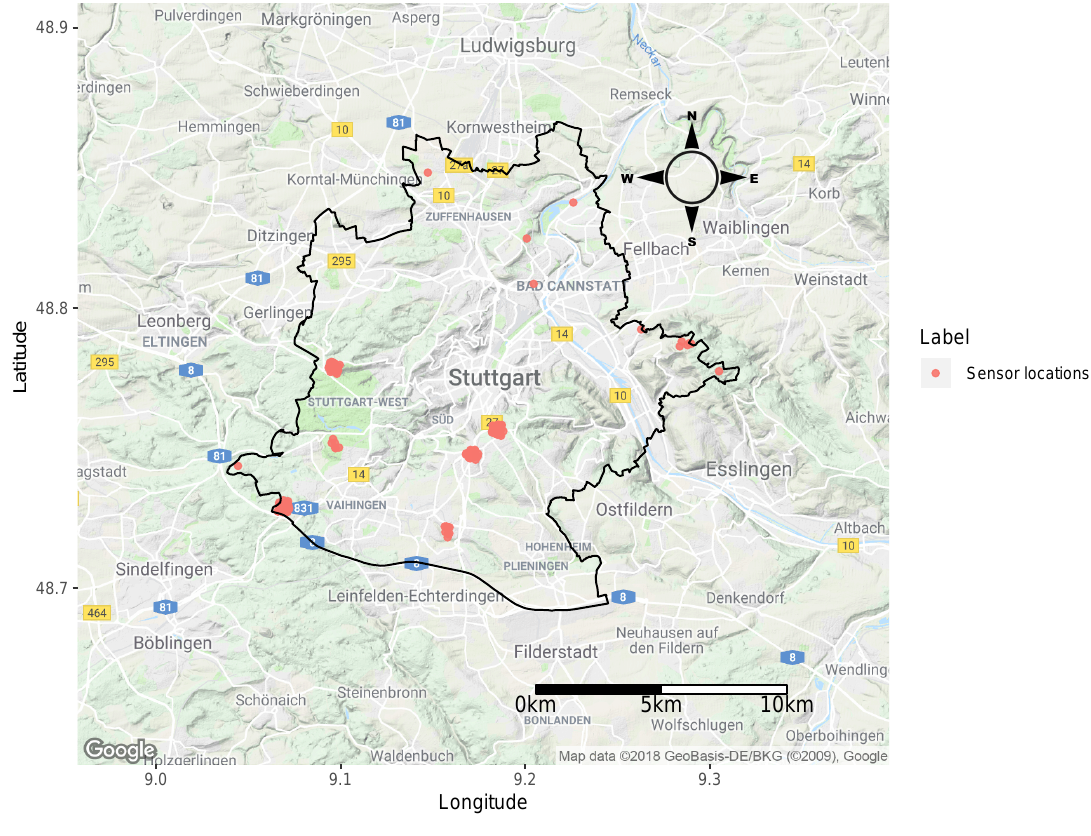
Figure 4. Optimisation outcome without using the spread aspect of the objective function ( N =